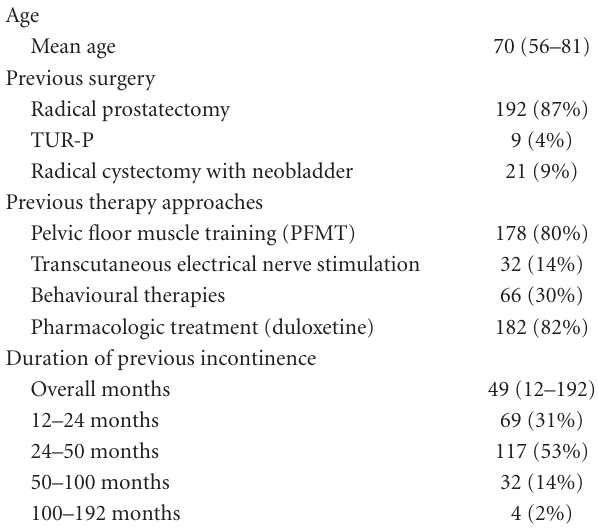
Table 1: Patient characteristics at